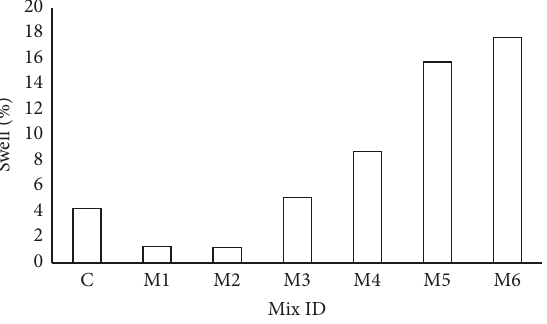
Figure 7: Swell percentage of various soil samples.